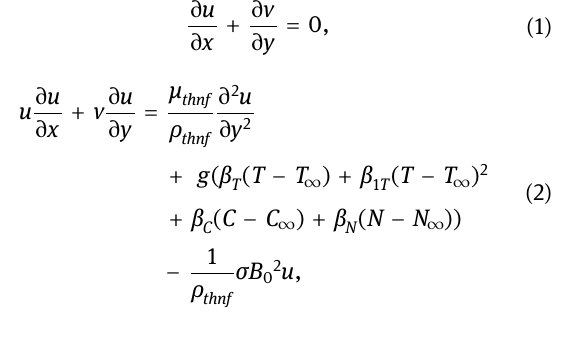
Table 1: The thermo - physical properties of distilled water conveying aluminum oxide, zinc oxide, and titanium dioxide